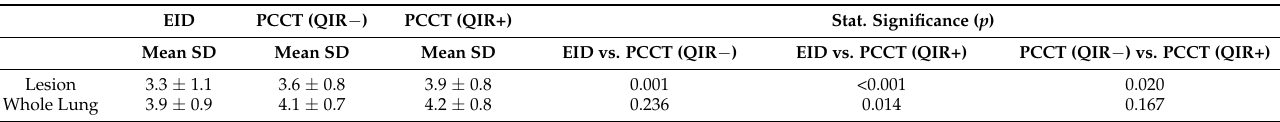
Table 2. Mean values with standard deviation (SD) for image sharpness on EID, PCCT (QIR − ) and PCCT (QIR+) images of enlarged lesions and the whole lung using a 5-point Likert scale as well as their associated p -values. Mean values are based on the rating on the Likert scale assessed by the readers (1—deficient, 2—sufficient, 3—satisfactory, 4—good, 5—very good). Statistical significance was assumed for p -values < 0.05.